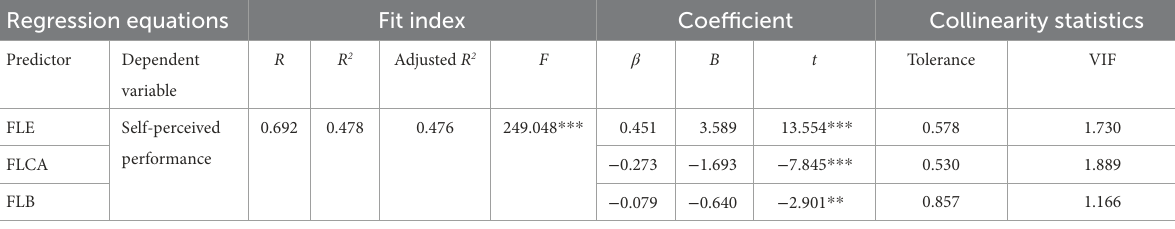
TABLE 7 Regression analysis with three emotions as predictors of self-perceived performance. Regression equations